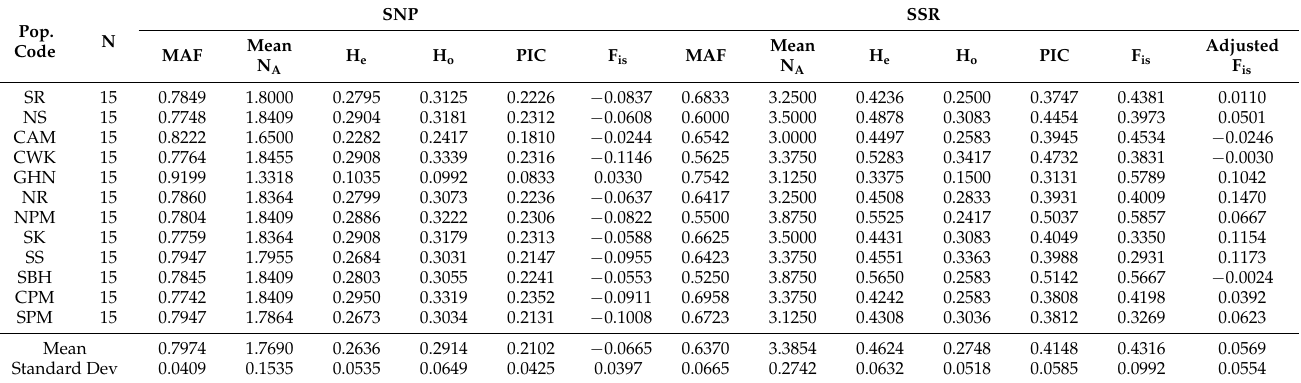
Table 3. Genetic diversity parameters of 180 samples in 12 populations using 220 SNP and 8